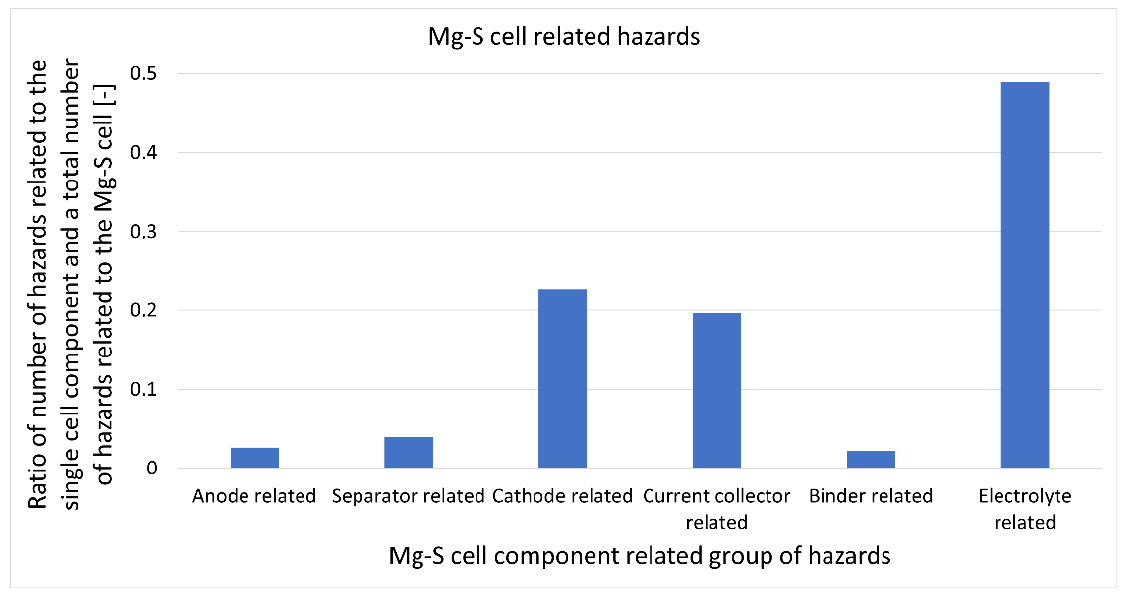
Figure 13. The ratio of the number of the hazards identified related to the single-cell component, and the total number of the hazards identified related to the Mg–S cell versus the Mg–S related group of